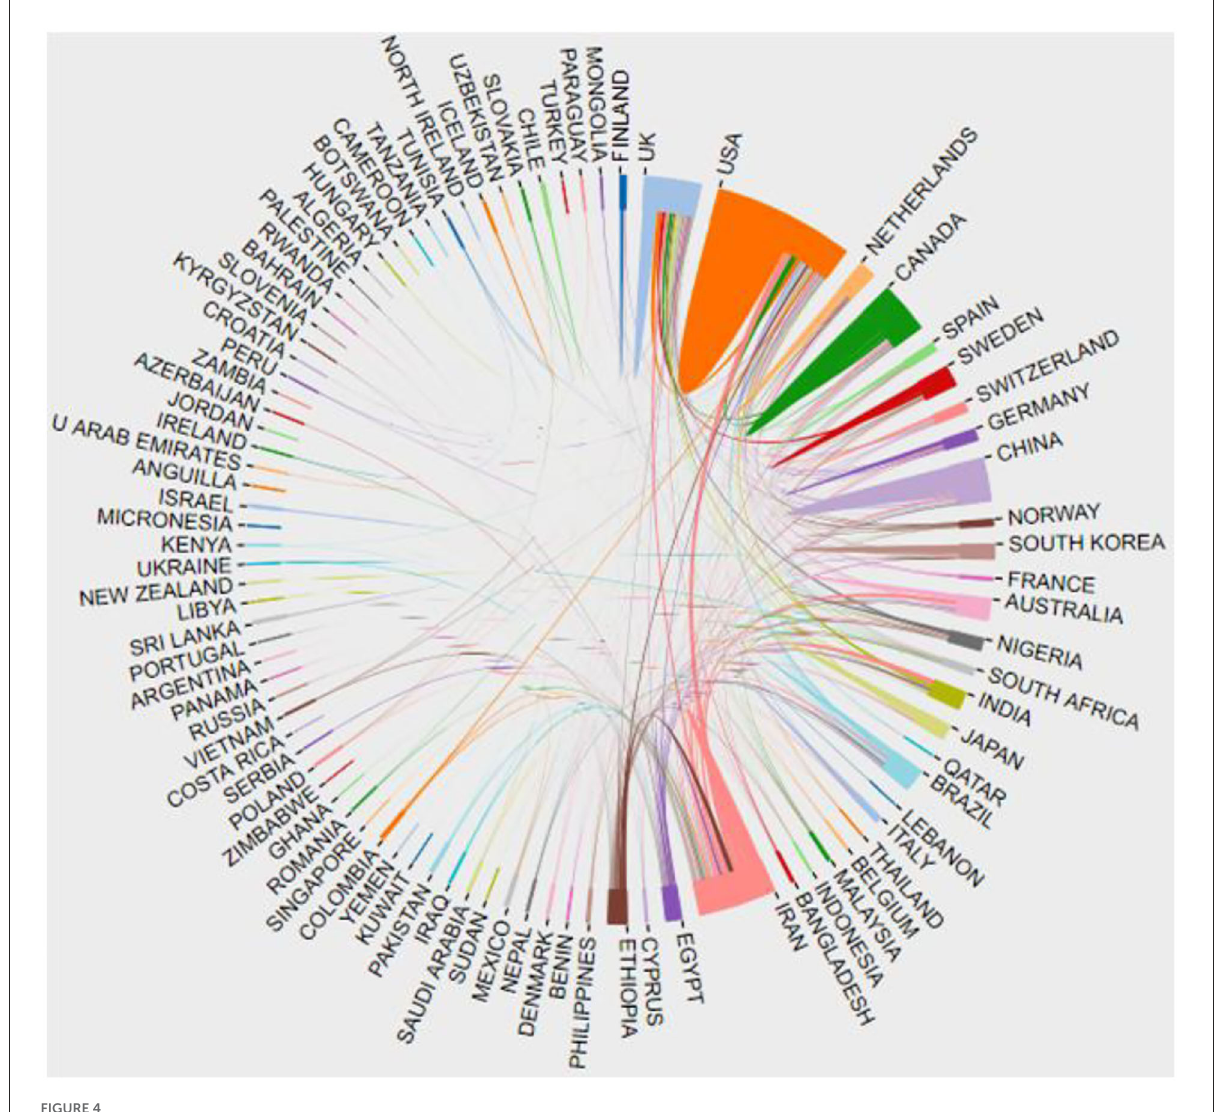
FIGURE4 Cooperation between